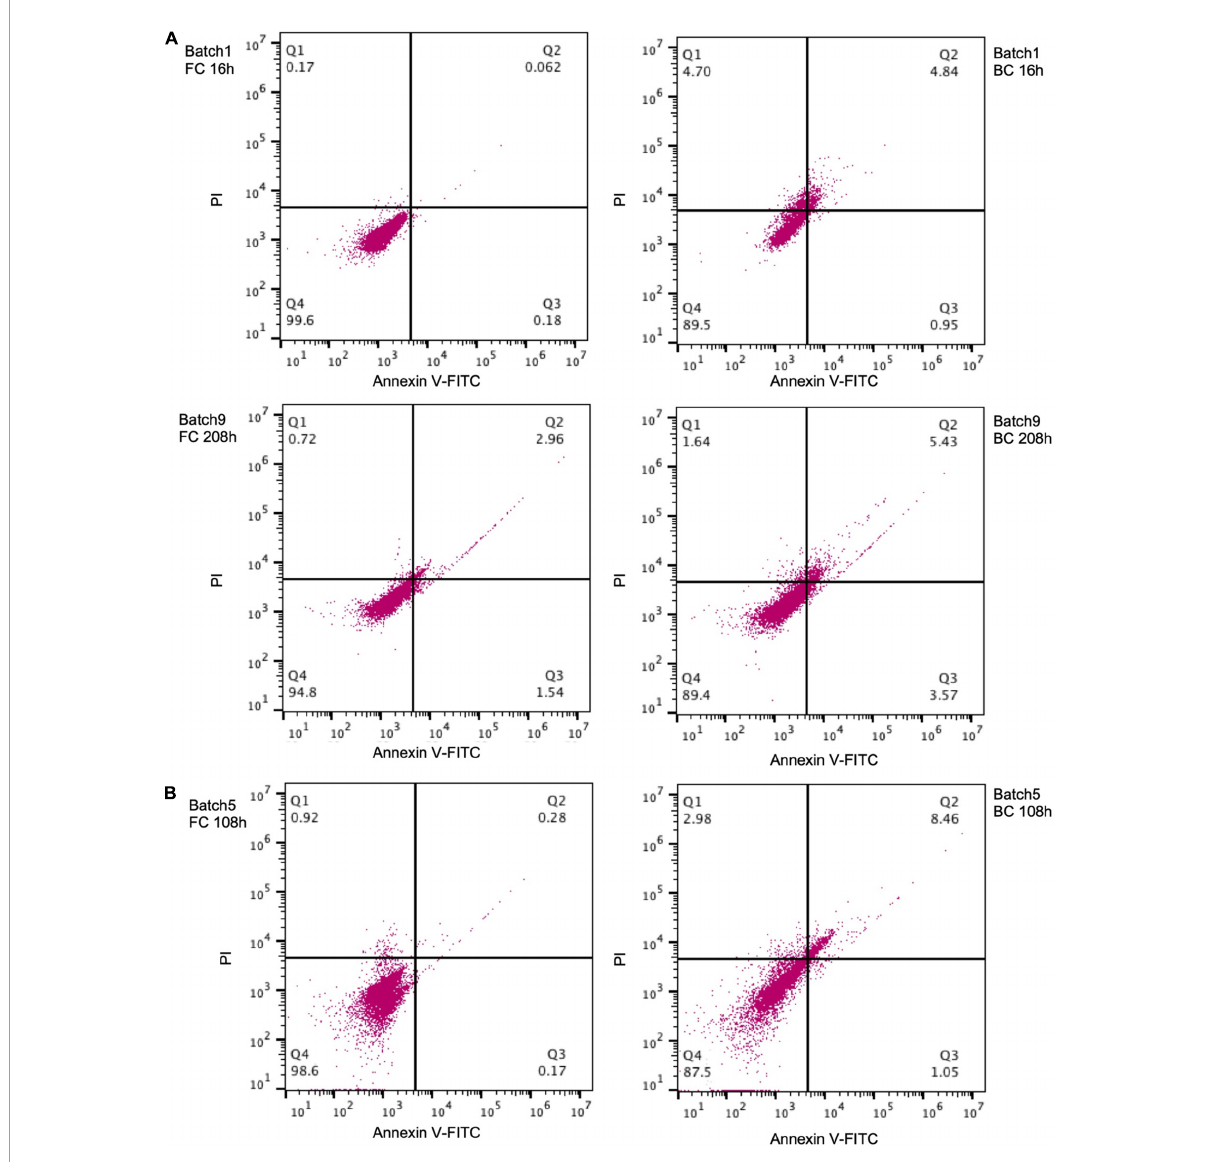
FIGURE6 Annexin V-FITC and PI staining of C. glutamicum biofilm cells (BC) and free cells (FC). (A) C. glutamicum ATCC13032 cells taken from batch 1 (16 h) and batch 9 (208 h) of fermentation. (B) Cg-0206 cells taken from batch 5 (108 h) of fermentation. The cell population in the Q4 region indicates negative cells, the Q1 region indicates PI positive cells, the Q2 region indicates Annexin V-FITC and PI positive cells, and the Q3 region indicates Annexin V-FITC positive cells. The number indicates percent of cells in each